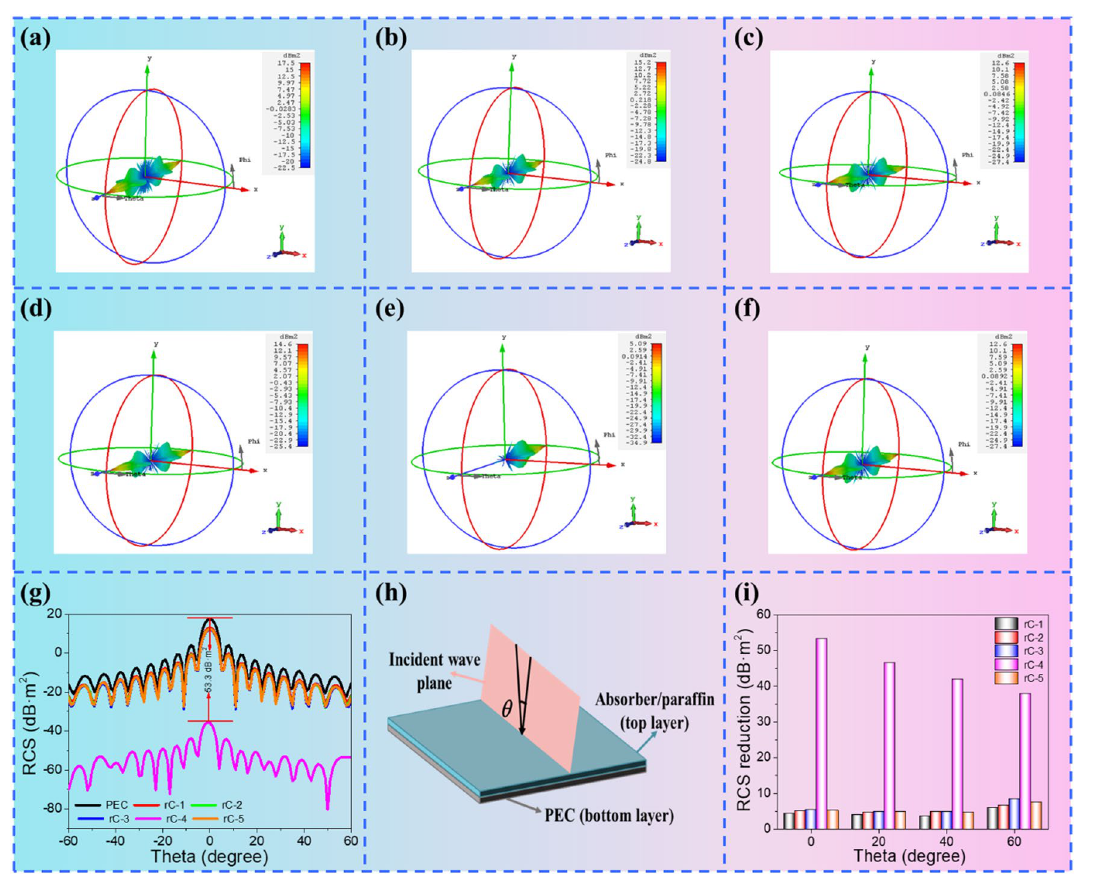
Fig. 6 3D radar wave scattering signals of a PEC, b rC-1, c rC-2, d rC-3, e rC-4 and f rC-5. g RCS simulated curves of PEC and RC composite aerogels. h Schematic diagram of CST simulation. i RCS reduction values of RC composite aerogels at the scanning angles of 0°, 20°, 40° and 60